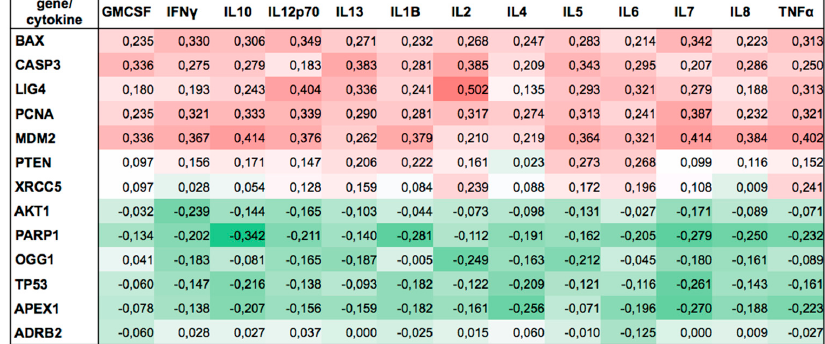
Figure 5. Association between changes in cytokines and corresponding changes in gene expression over the eight experimental conditions for the group of samples irradiated with 2 Gy. BAX, CASP3, PCNA, LIG4, and MDM2 gene expressions were positively associated, while AKT1, TP53, PARP1, OGG1, and APXE1 were negatively associated with cytokines.